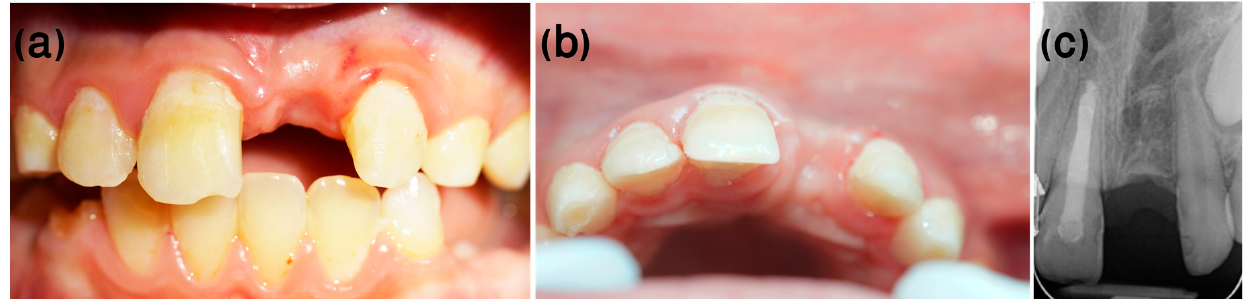
Figure 8. Case 1, one-year post-surgery follow-up. ( a , b ) Clinical appearance. ( c ) Replacement resorption progression and bone apposition coronal to the resected root are evident.